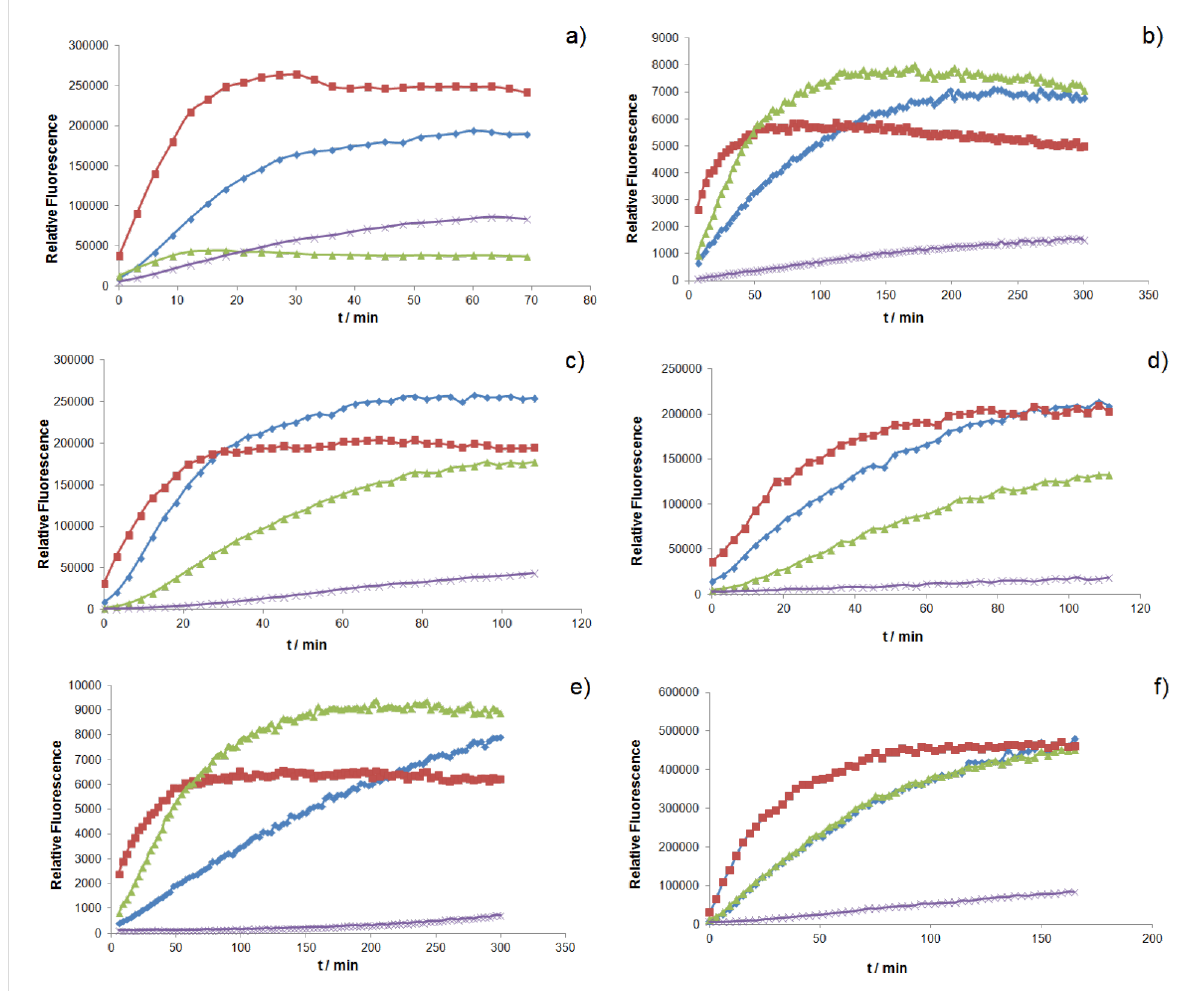
Figure 2: Fluorescence evolution resulting from closing metathesis of umbelliferone precursor 8 ( λ excitation = 350 nm and λ emission = 380 nm). Different catalysts 1 – 4 ( 1 : blue; 2 : red; 3 : green; 4 : purple) were screened in different solvents (a: acetic acid; b: 2-methylpentanone; c: toluene; d: o -xylene; e: γ -butyrolactone; f: